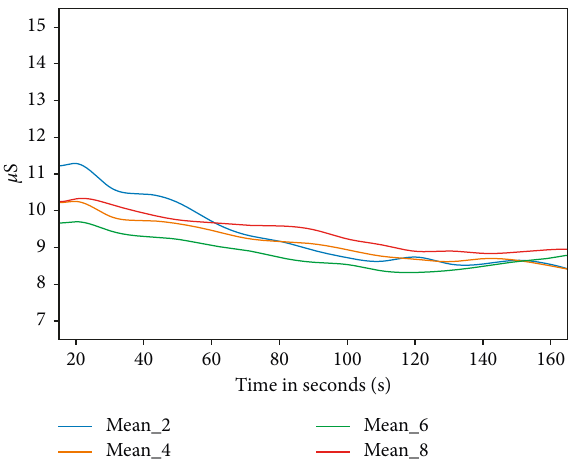
Figure 12: Plot of graphs of SCL averaged over all subjects for each density for the time range relevant to the